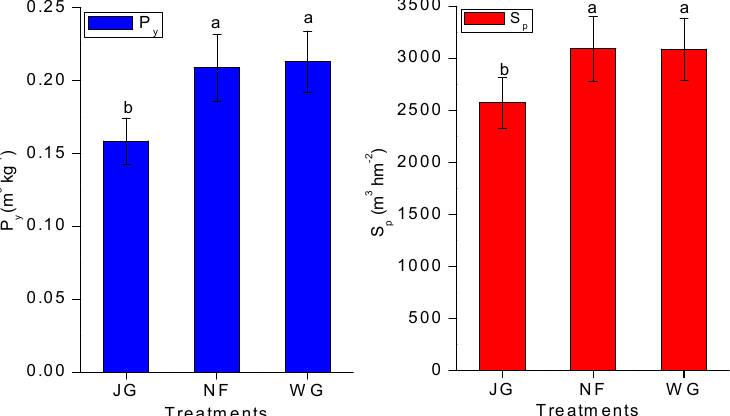
Figure 6. Water saving potential per unit yield and per unit area of maize under various surface mulching patterns. Note: JG represents straw mulching; NF represents organic fertilizer mulching; WG represents no mulching; P y represents water saving potential per unit yield, m 3 kg − 1 ; S p represents water saving potential per unit area, m 3 hm − 2 . Bars labeled with different letters (lowercase) differed significantly among the treatments ( p < 0.05).